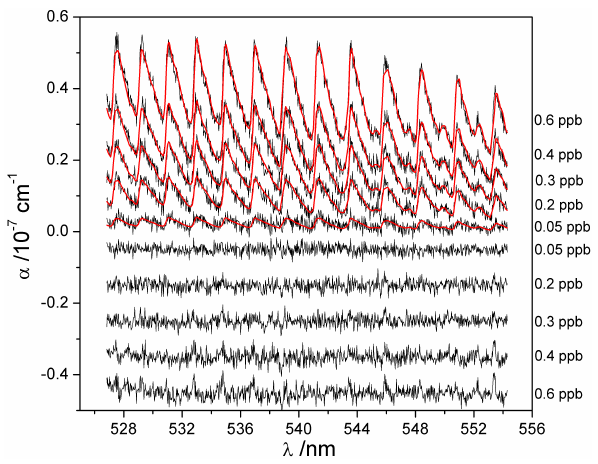
Fig. 6. Series of extinction spectra obtained with the IBBCEAS set up for different I 2 mixing ratios. The red lines are the fits to Eq. (3) using a reference spectrum (Saiz-Lopez et al., 2004) convolved to the instrument resolution (0.22nm FWHM). The residuals of the fits are translated vertically for clarity.